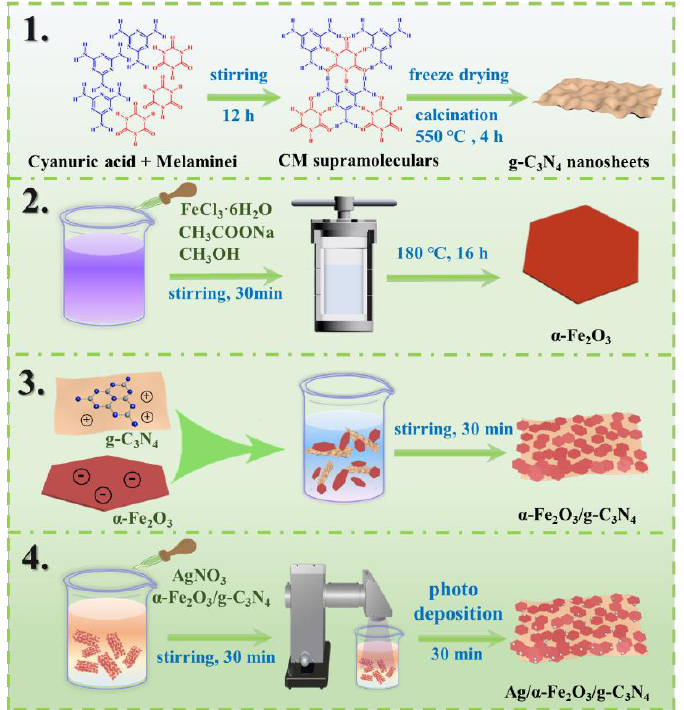
Figure 1. Scheme diagram of the preparation process of Ag/ α -Fe 2 O 3 /g-C 3 N 4 sandwich-like self-assembled S-Scheme heterojunction photocatalyst.